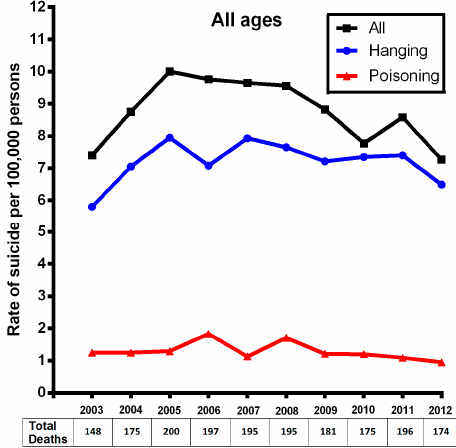
Figure 1. Suicide rate per 100,000 persons including all age groups.